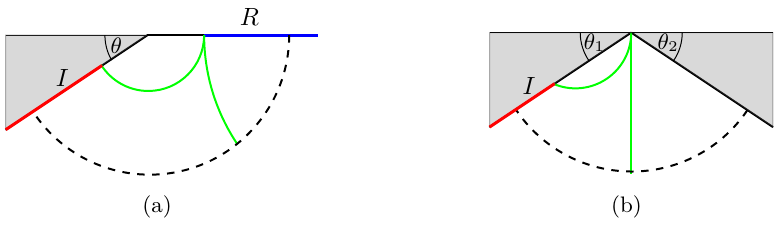
Figure 1 . Left: Karch/Randall model for non-gravitating bath. The figure shows part of AdS 5 with the ETW brane cutting off the shaded region. The dashed curve is the black hole horizon and R is the radiation region (blue). The green curve ending on the horizon represents the HM surface; the green curve extending from the boundary of R to the ETW brane is the island surface. I is the island (red). Right: for a gravitating bath a second ETW brane is introduced, leaving only a 3-dimensional part of the conformal